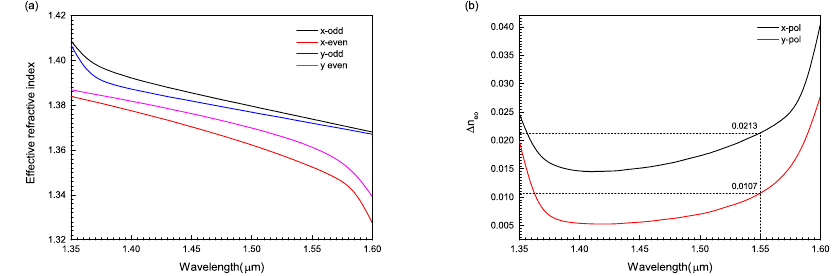
Figure 4. Variation of refractive index ( a ) and refractive index difference ( b ) with wavelength. The variation of the coupling length of circular two-core PCF with wavelength and the variation of the normalized power with distance are shown in Figure 5. From Figure 5a, as the wavelength increases from 1.35 to 1.60 µ m, the coupling length in the x- and y- polarized directions first increases and then decreases, and the coupling ratio between them also first increases and then decreases. At the communication wavelength of 1.55 µ m, the coupling ratio reaches the best value of 2. In addition, at the same wavelength, the coupling length in the x-polarized direction is much smaller than that in the y-polarized direction, because the coupling strength between the mode on the surface of As 2 S 3 rod and the core mode in the x-polarized direction is much stronger than that in the y-polarized direction. From Figure 5b, when the wavelength of the input light wave is 1.55 µ m, the coupling lengths in x- and y-polarized directions are 36.38 µ m and 72.43 µ m, respectively, which basically meets 2 CL x = CL y = 72.43 µ m. Therefore, the two polarized lights can be completely separated. This shows that when the length of the polarization beam splitter is 72.43 µ m, the core of the incident light only has the light in the x-polarized direction, while the light in the y-polarized direction has been completely coupled into another core, so the circular double-core PCF with this length can be made into a polarization beam splitter. The beam splitting length of x- and y-polarized light in the circular dual-core PCF is 72.43 µ m, which is difficult to operate in practical preparation. However, in the dual-core PCF, the coupling and splitting of x- and y-polarized light in the two cores is periodic, so the splitting effect can still be achieved after the splitting length is multiplied by different multiples. Since the beam splitting length of the circular dual-core PCF belongs to the extremely short beam splitting, the number of beam splitting lengths obtained by multiplying it by different multiples is more, so more beam splitting lengths are selected during preparation. Among the polarization beam splitters reported at present, the beam splitting length of this structure is relatively short, which is of great significance to the future application of this polarization beam